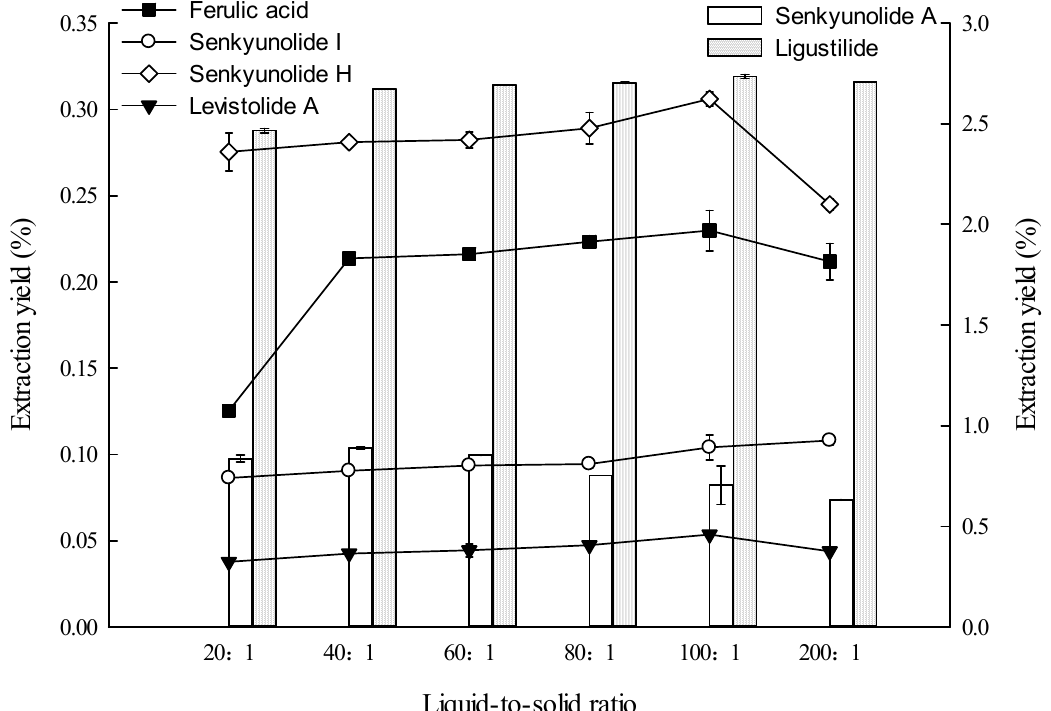
Figure 4. Effects of liquid-to-solid ratio on the extraction yields of the six constituents (the lines and bar graphs are referenced to the left and right axes,